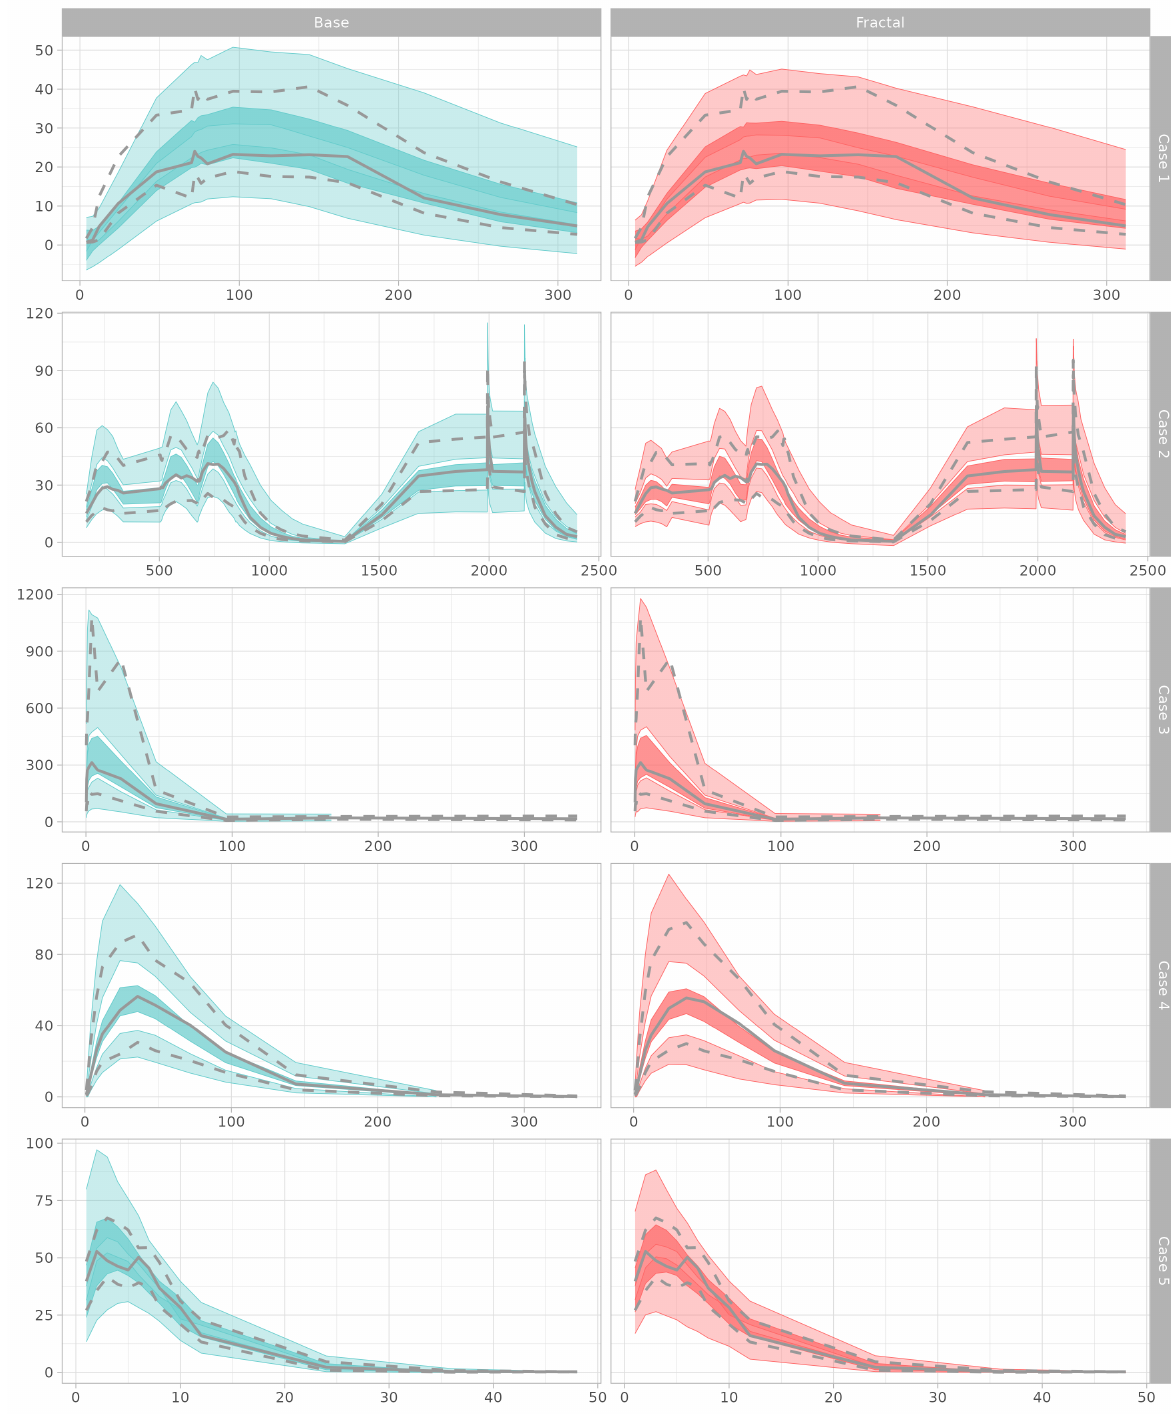
Figure 6. Model performance. Differences are displayed from the mean value of five model